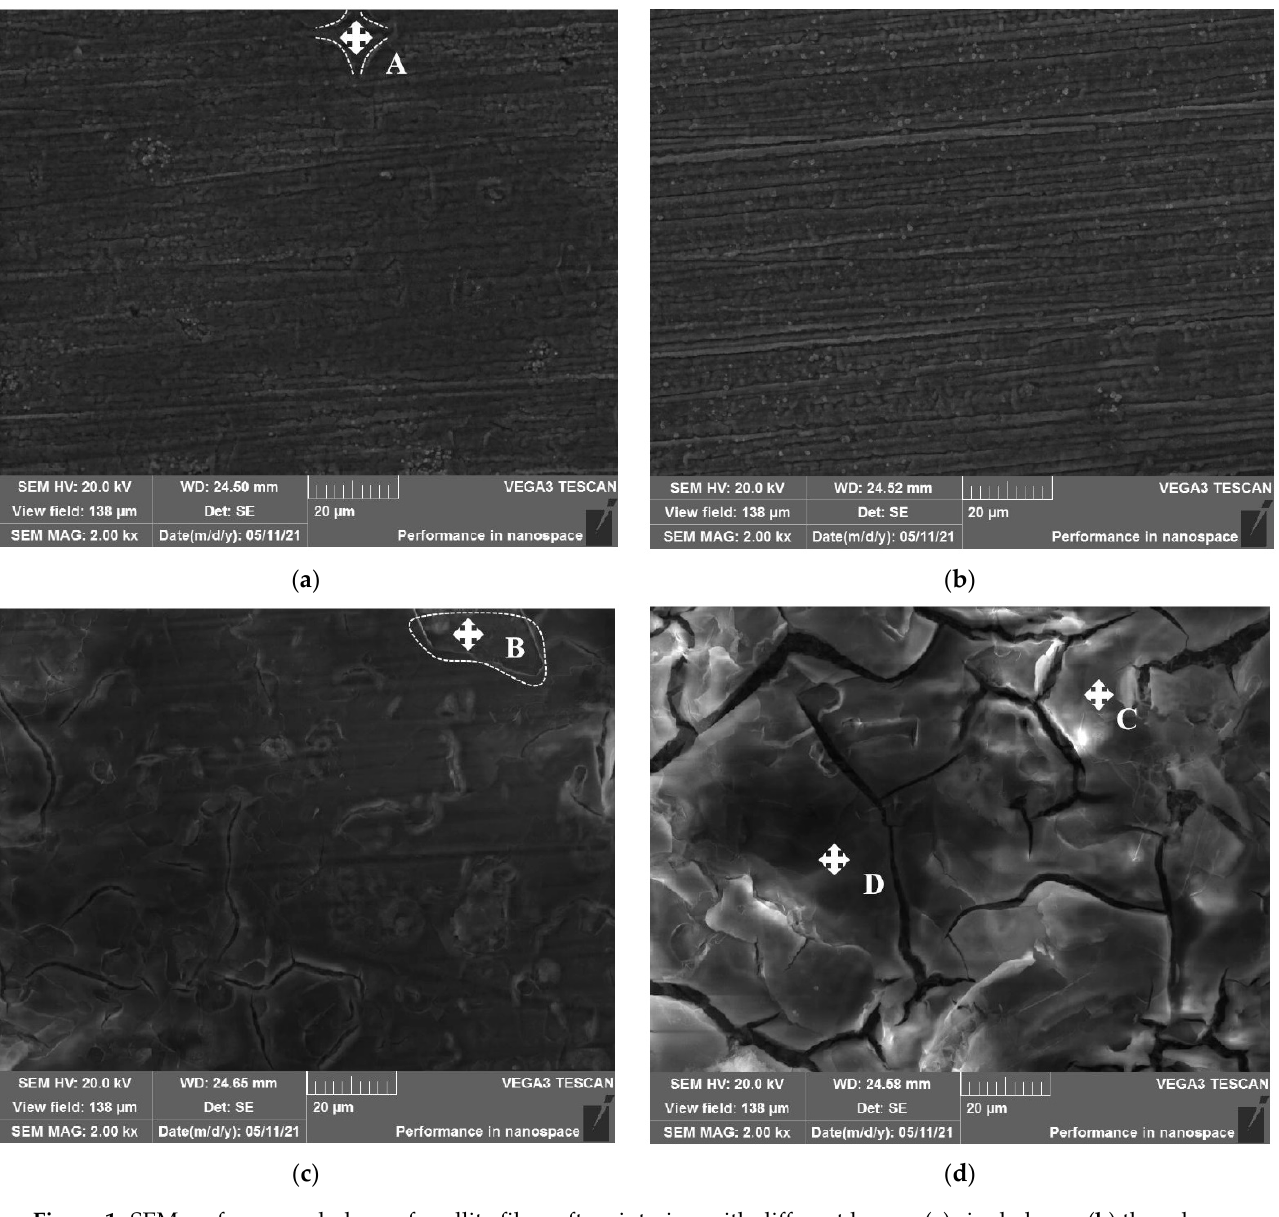
Figure 1. SEM surface morphology of mullite films after sintering with different layers: ( a ) single-layer; ( b ) three-layer; ( c ) six-layer; ( d ) nine-layer.